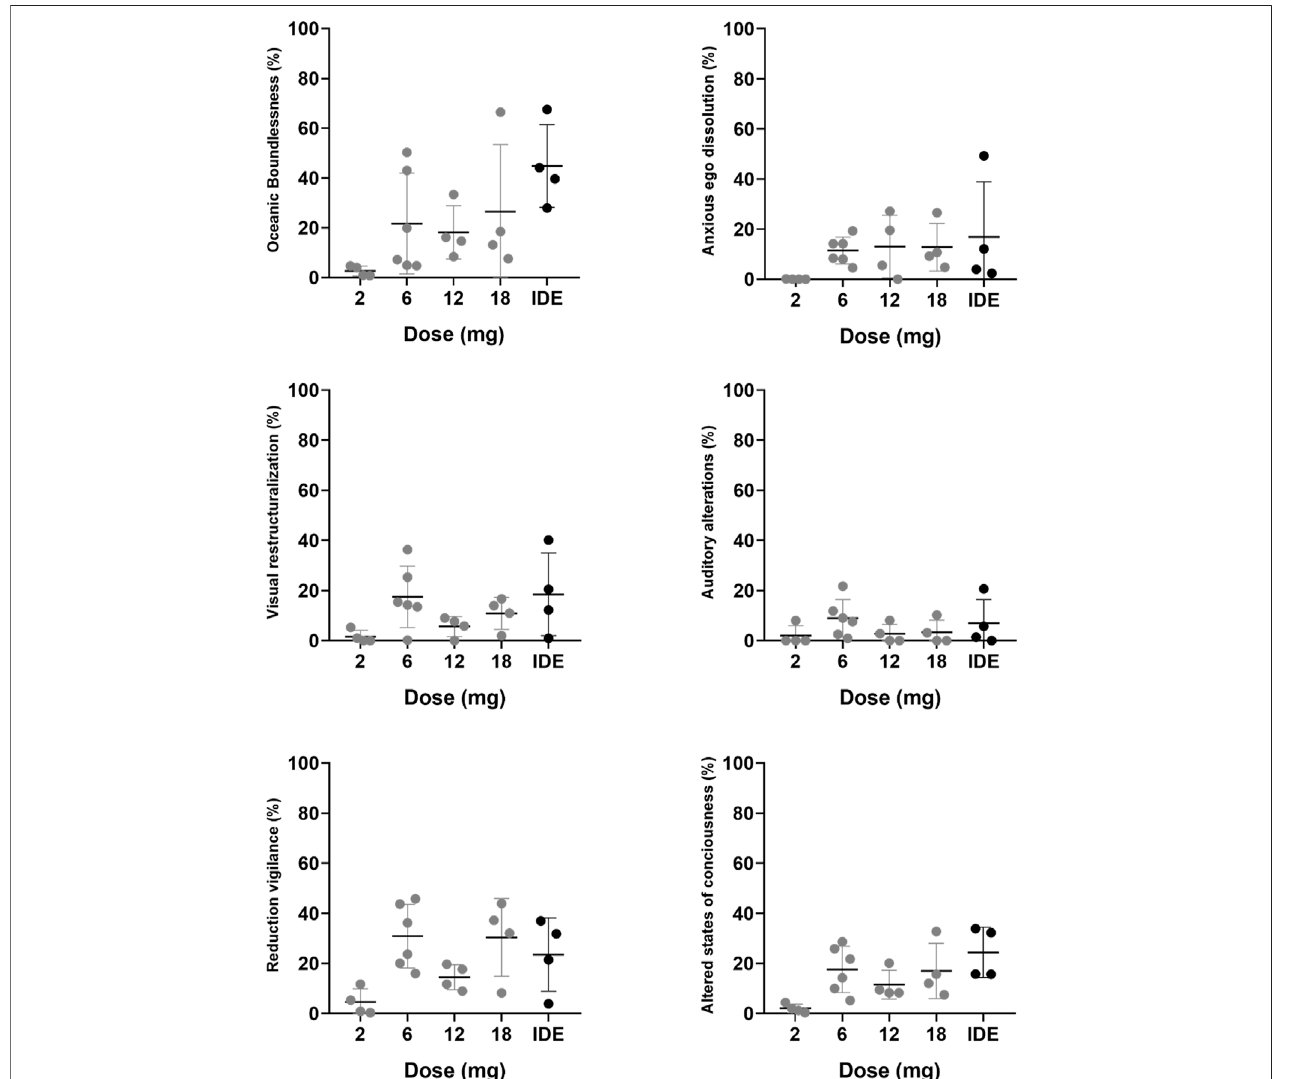
FIGURE 2 | Mean (SE) and individual retrospective ratings of the acute psychedelic experience per dose level for 5 key-dimensions on the 5D-ASC and the overall score.